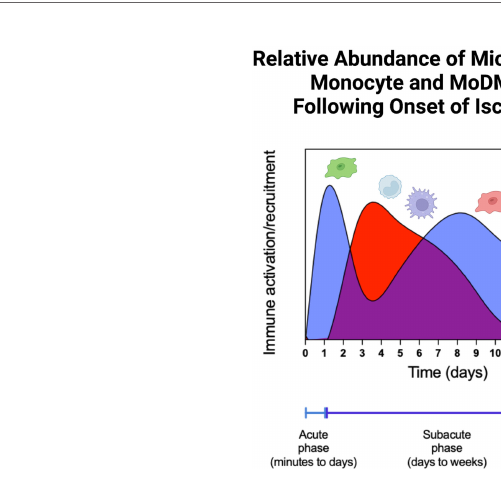
FIGURE 3 | Relative Abundance of Microglia, In fi ltrating Monocyte, and MoDM Subtypes Following Onset of Ischemic Stroke. During the acute phase of stroke, microglia are activated and predominantly found in the M2, anti-in fl ammatory phenotypic state. These M2 microglia then wane during the early subacute phase, giving rise to the M1 microglia during the late subacute and chronic stages. Classical monocytes (CCR2 + , Ly6C high cells in mice, CD14 ++ CD16 - cells in humans) in fi ltrate the brain parenchyma from days 3-5 and differentiate into M1 pro-in fl ammatory MoDMs. After day 7, the quantity of MoDMs slowly returns to baseline levels, which are reached by day 14. During this time, non-classical monocytes (CCR2 - , Ly6C low cells in mice, CD14 + CD16 ++ cells in humans) and the differentiated M2 MoDMs predominate. MoDM, monocyte derived macrophage; CCR2, C-C Motif Chemokine Receptor